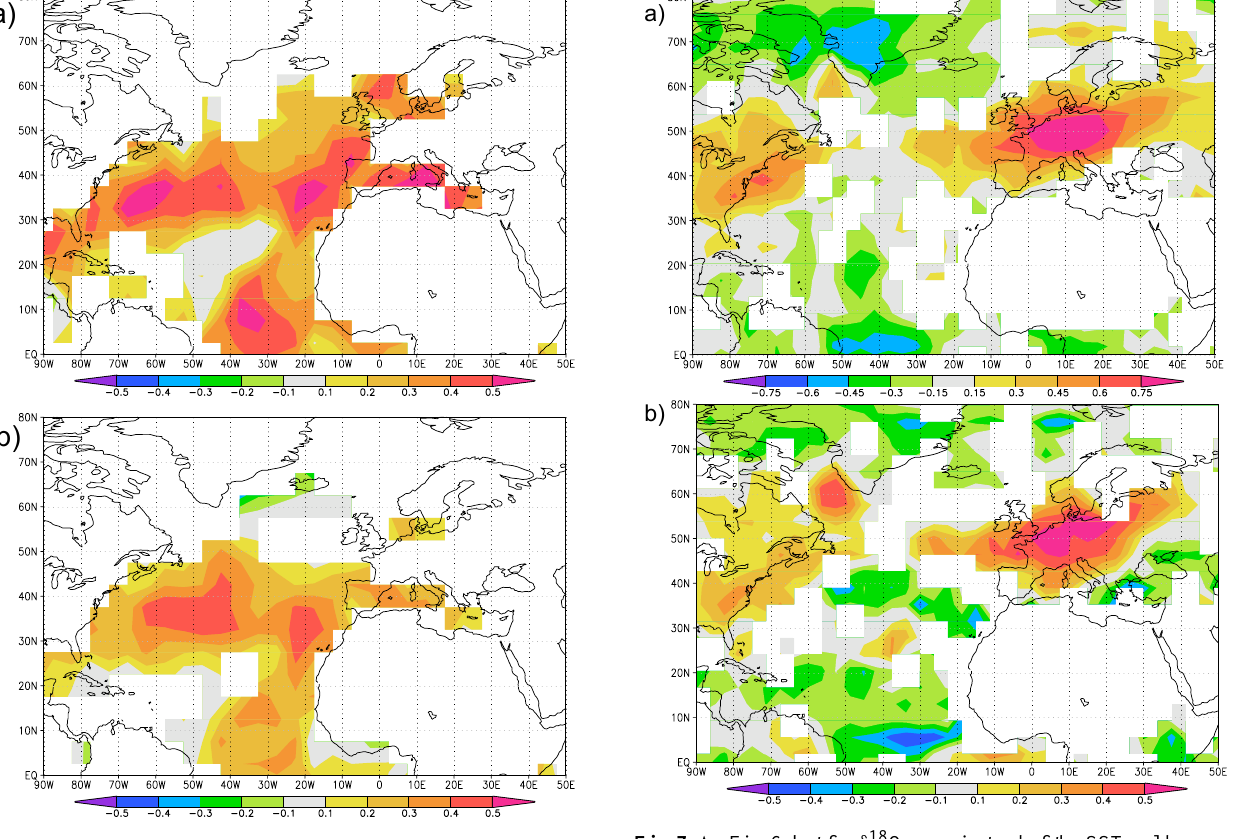
Fig. 6. (a) In-phase correlation of the simulated local δ 18 O precip values and SST. (b) 3-yr lag correlation of the simulated δ 18 O calc values and SST. Areas showing a significant correlation (95% con- fidence level, t-test) are coloured. The data were detrended, and a 5-yr low-pass filter was applied (see text).